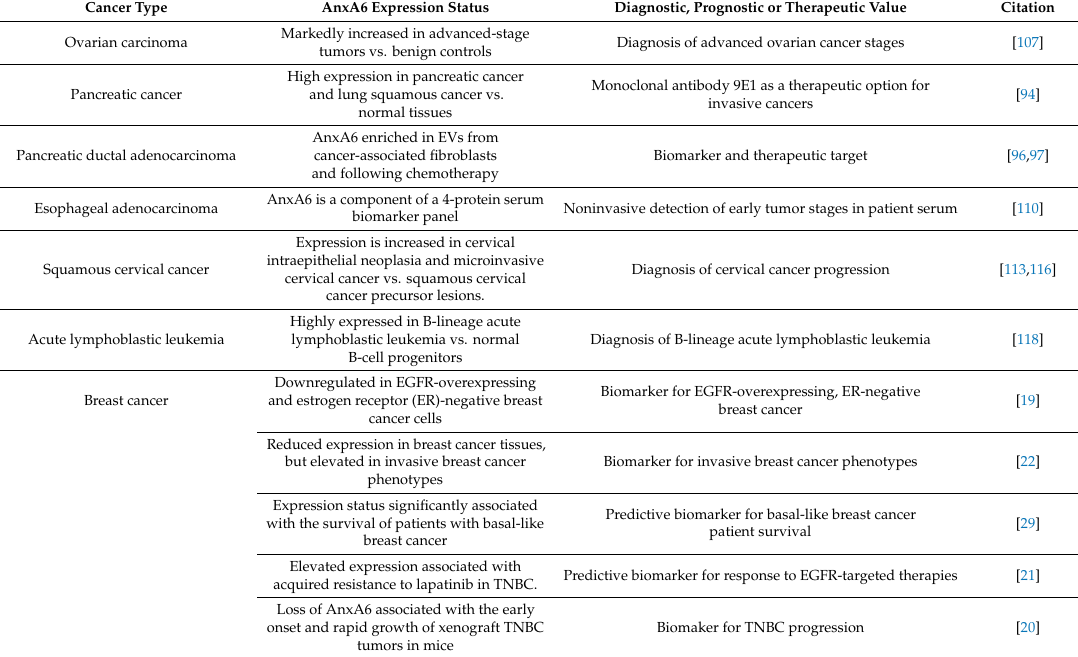
Table 1. Diverse diagnostic, prognostic and therapeutic significance of AnxA6 in cancer